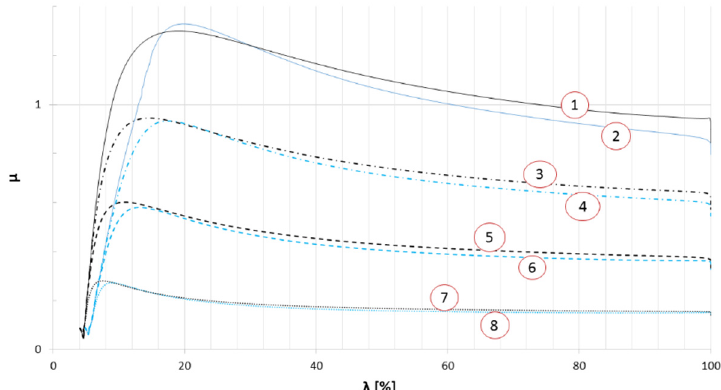
Figure 2. The µ versus λ curves for the different road surfaces for the studied vehicle model: 1—dry road rear wheels, 2—dry road front wheels, 3—damp road rear wheels, 4—damp road front wheels, 5—wet road rear wheels, 6—wet road front wheels, 7—icy road rear wheels, 8—icy road front wheels.